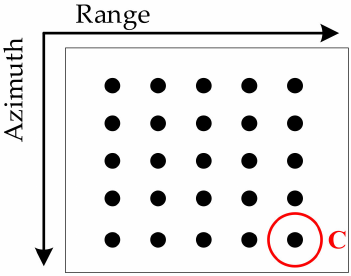
Figure 16. Geometry of simulated point targets. Figure 17 show the imaging results obtained by MESRM and R4-ESRM combined with the proposed imaging algorithm at different position in HEO. The SAR echo data of several representative positions in highly elliptical orbit: perigee, squint subduction section and apogee were used for imaging based on MESRM and R4-ESRM, respectively.